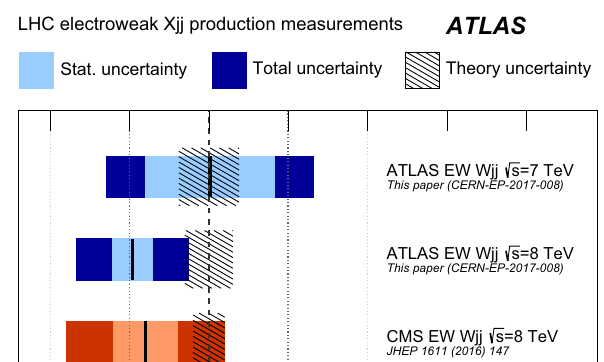
> 20 GeV jets are also shown T [fb] Acceptance A σ inc meas [fb] SM